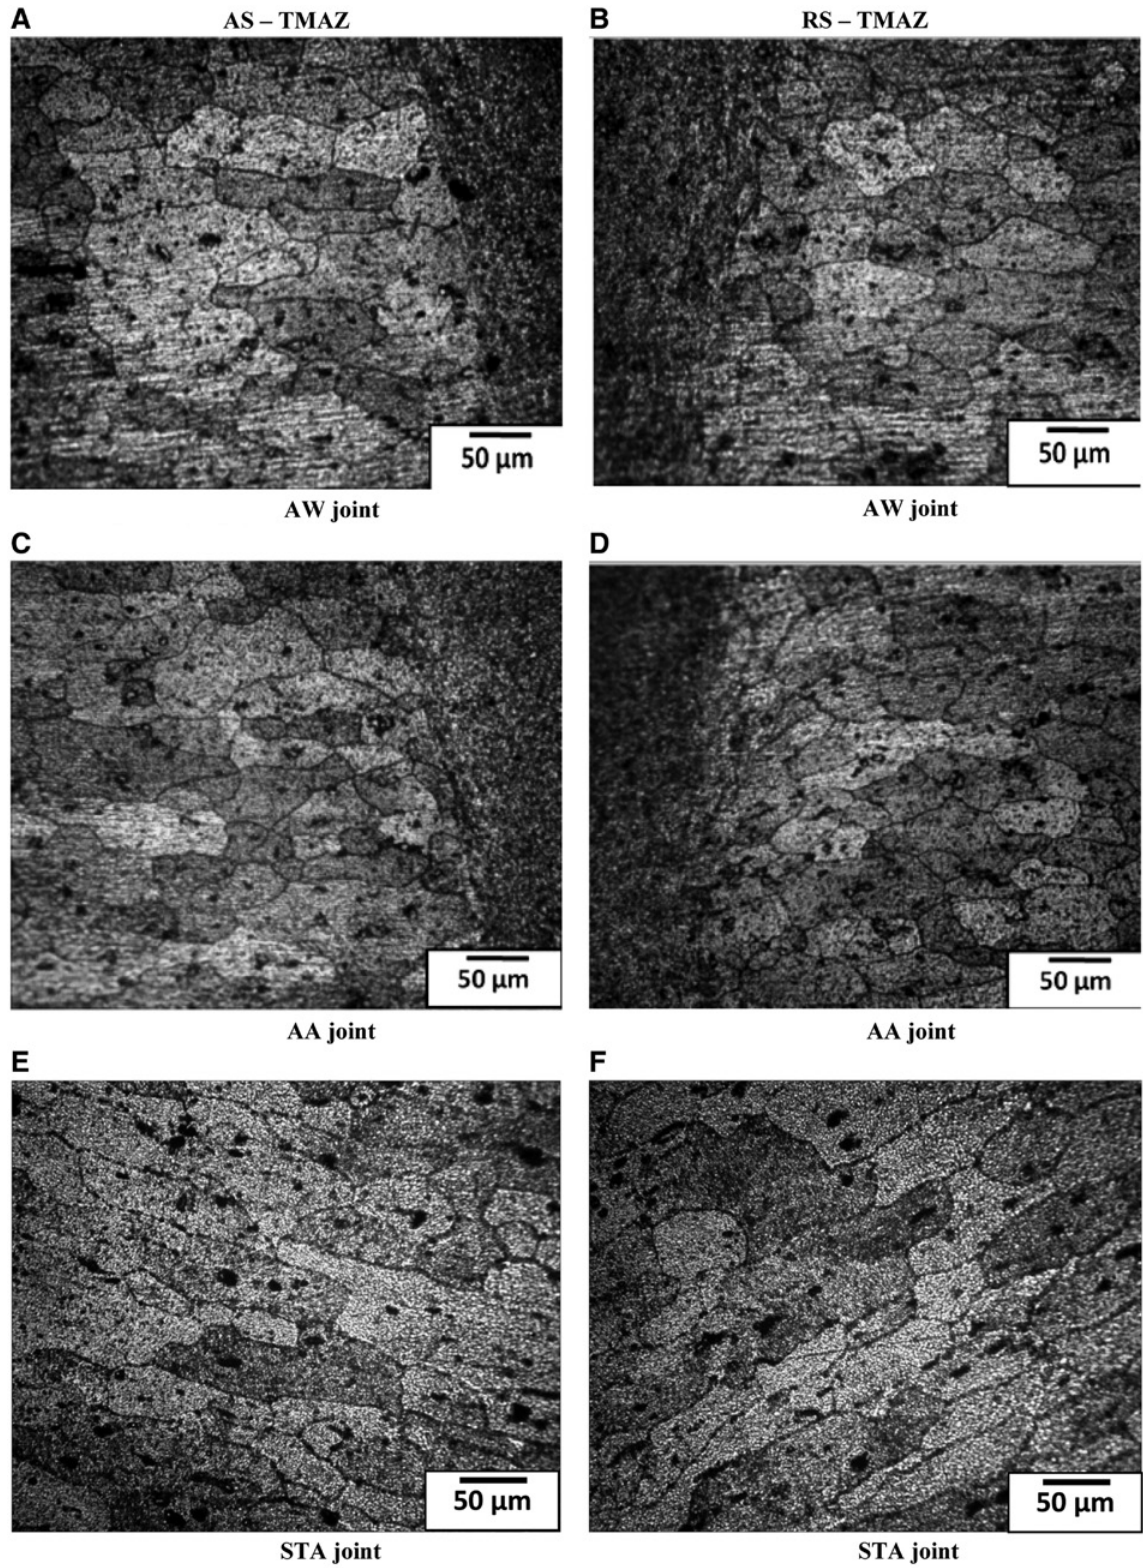
Figure 5: Optical micrographs of interface regions of welded